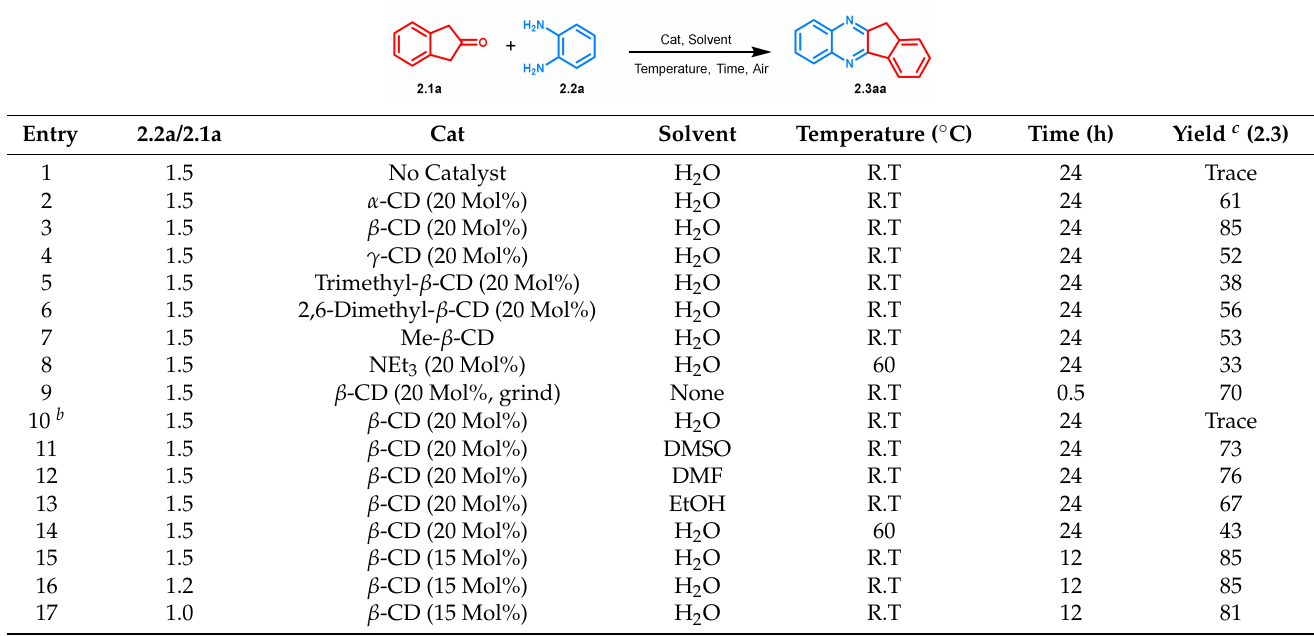
Table 1. Optimization of reaction conditions in the synthesis of indeno[1,2-b]quinoxaline from 2-indanone and OPD a